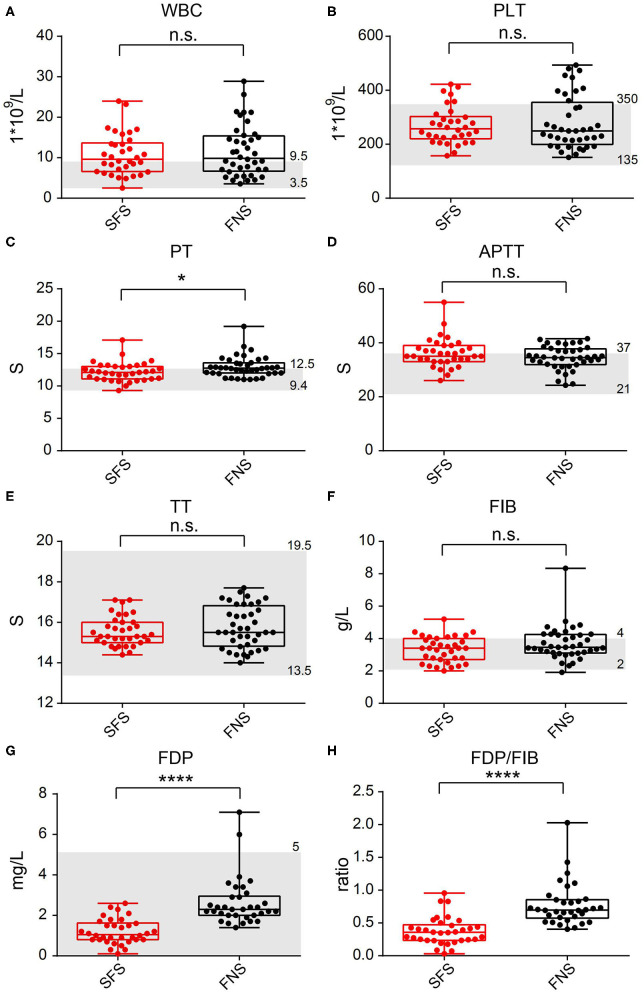
Comparison of laboratory test indicators between the SFS and FNS groups. (A) WBC. (B) PLT. (C) PT. (D) APTT. (E) TT. (F) FIB. (G) FDP. (H) FDP/FIB. n.s.: not significant; *P < 0.05; ****P < 0.0001. The gray area represents the clinical normal range.